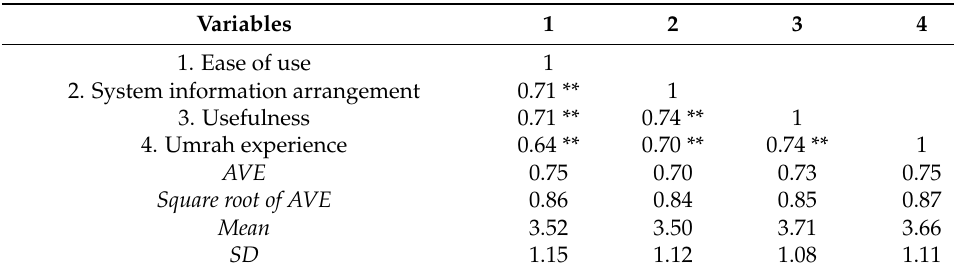
Table 3. A correlation matrix of different